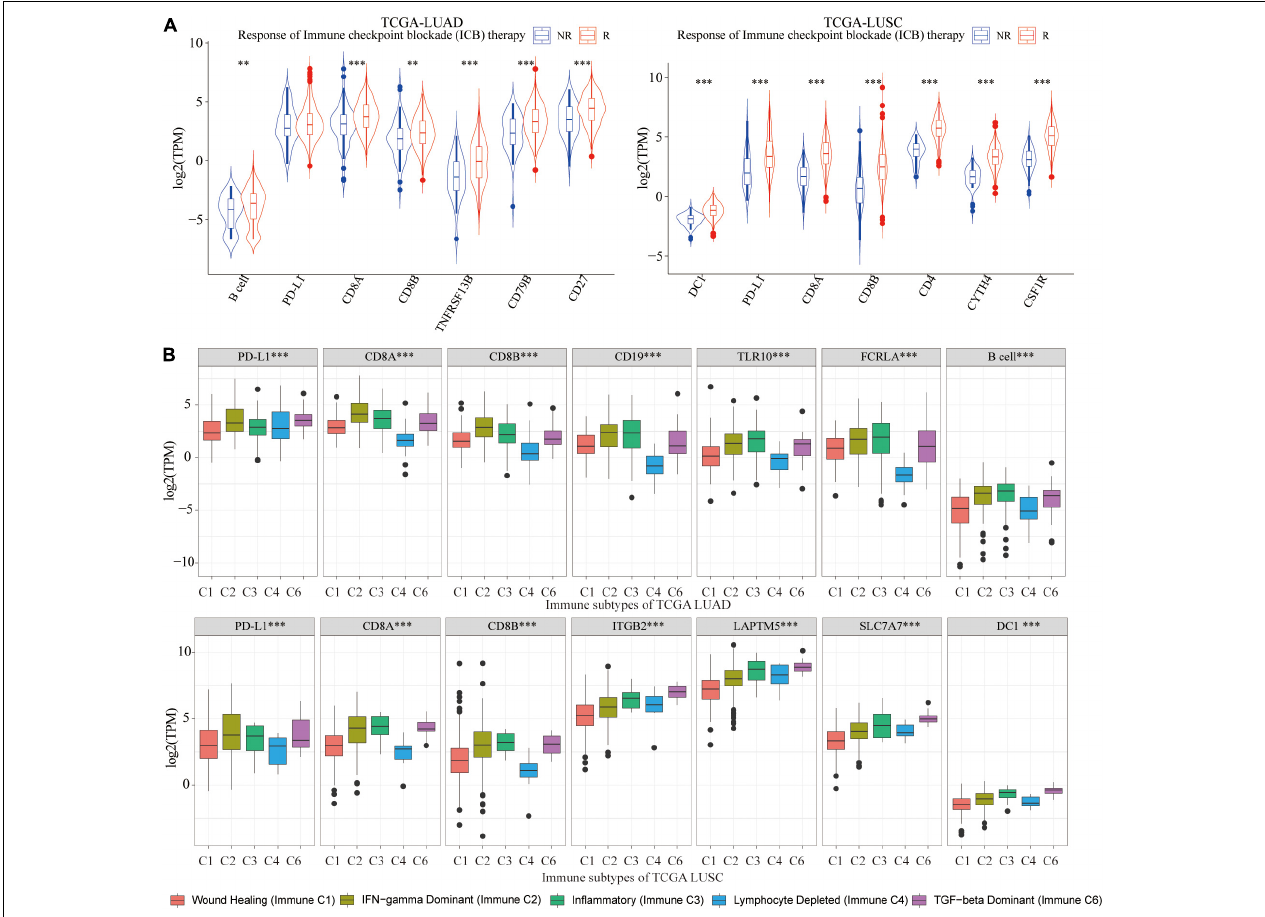
FIGURE 10 | Correlation with ICB treatment and immune subtypes. (A) For LUAD, in the ICB response group, B cell abundance, and three hub genes were significantly higher, whereas in LUSC, there were significantly higher abundance of DC1 and expression of three hub genes. (B) Among five immune subtypes, immune C2, C3, and C6 had a higher abundance of B cell and DC1 and expression of CD8A, CD8B, and six hub genes. ** p < 0.01, *** p <